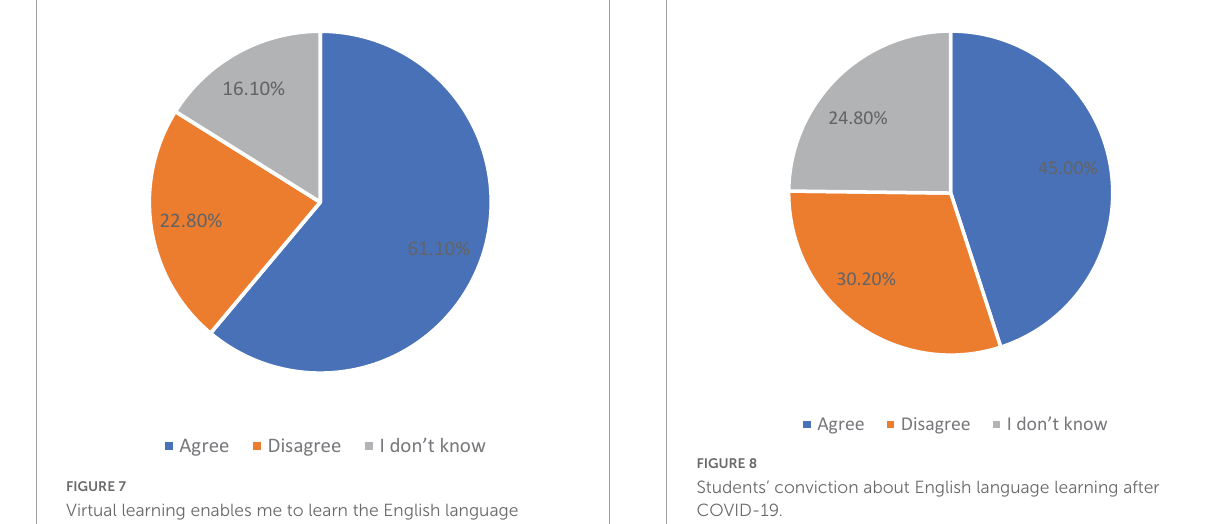
FIGURE8 Students’ conviction about English language learning after